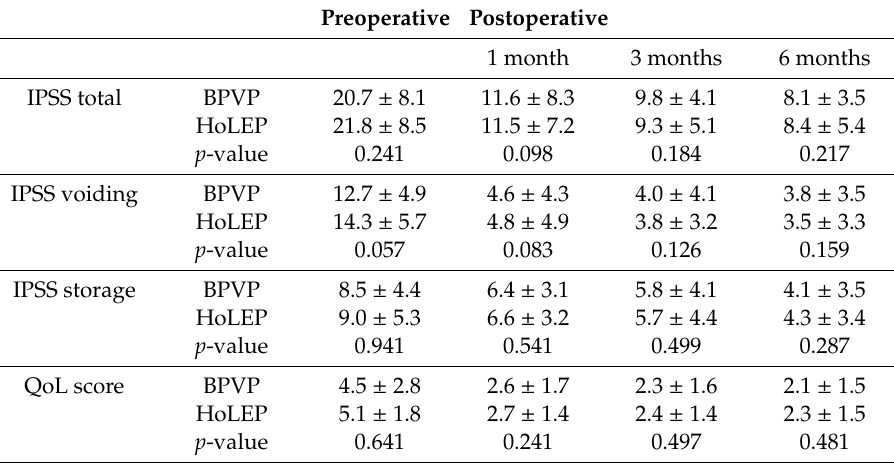
Table 4. Postoperative 6-month IPSS, IPSS voiding, IPSS storage, and QoL